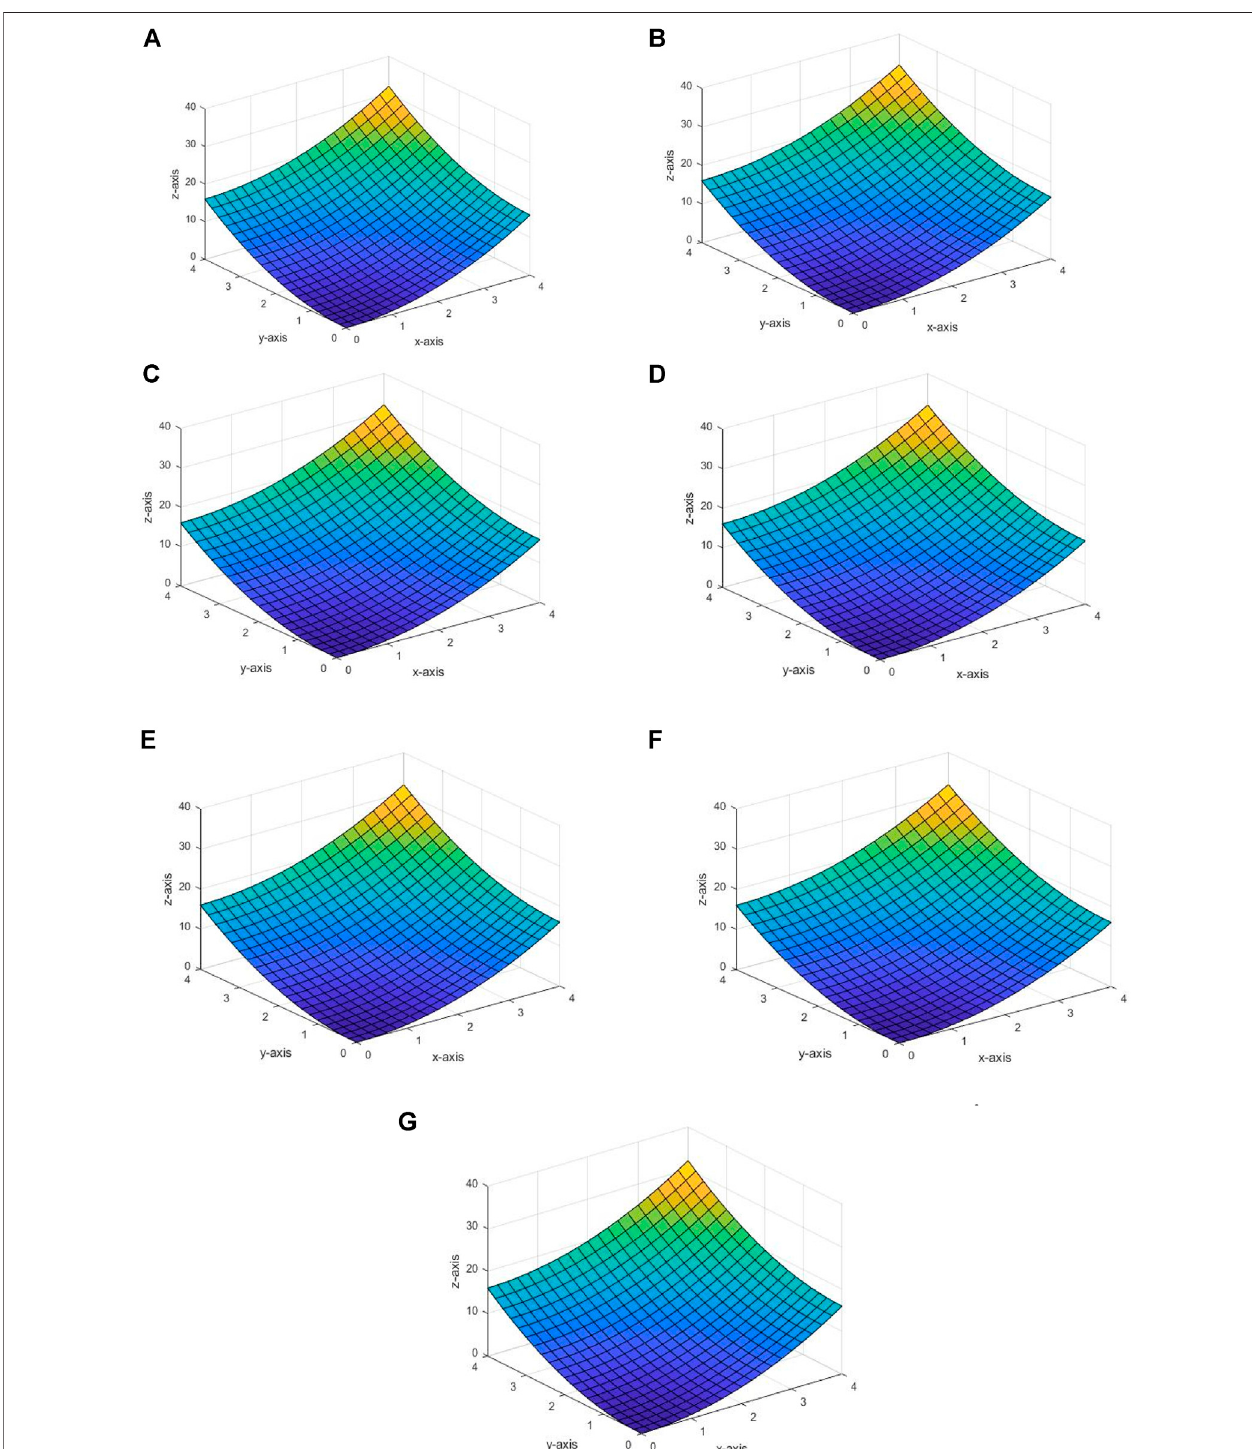
FIGURE5| Localquadraticpolynomialreproducing. (A) Truefunction. (B) α i , j (cid:2) β i , j (cid:2) 1 , (cid:4) α i , j (cid:2) (cid:4) β i , j (cid:2) 1,and c i , j (cid:2) (cid:4) c i , j (cid:2) 1 . (C) α i , j (cid:2) β i , j (cid:2) (cid:4) α i , j (cid:2) (cid:4) β i , j (cid:2) 1 , c i , j (cid:2) (cid:4) c i , j (cid:2) 0 . 02. (D) α i , j (cid:2) β i , j (cid:2) (cid:4) α i , j (cid:2) (cid:4) β i , j (cid:2) 1 , c i , j (cid:2) (cid:4) c i , j (cid:2) 0 . 002 . (E) β i , j (cid:2) (cid:4) α i , j (cid:2) (cid:4) β i , j (cid:2) 10 , c i , j (cid:2) (cid:4) c i , j (cid:2) 1 . (F) α i , j (cid:2) β i , j (cid:2) (cid:4) α i , j (cid:2) (cid:4) β i , j (cid:2) 100 , c i , j (cid:2) (cid:4) c i , j (cid:2) 1 . (G) α i , j (cid:2) β i , j (cid:2) 1000 , (cid:4) α i , j (cid:2) (cid:4) β i , j (cid:2) 1000 , and c i , j (cid:2) (cid:4) c i , j (cid:2) 1 .